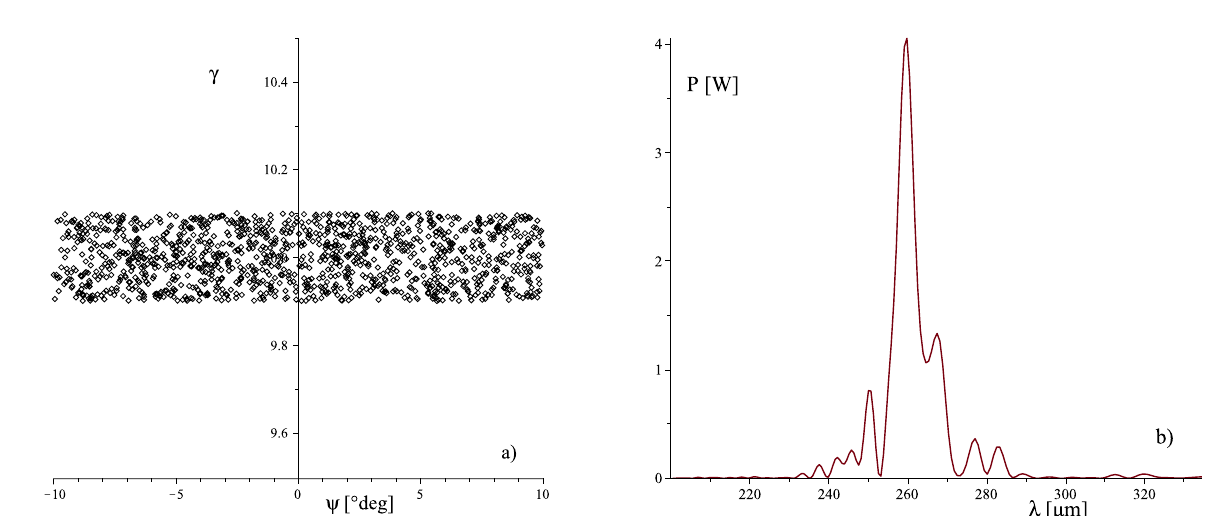
Figure 5. Emission by undulator – radiator: not the modulated case: ( a ) phase-space; and ( b ) power spectrum.